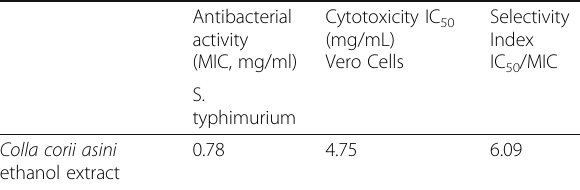
Table 4 Cytotoxicity (IC 50 in mg/mL) of Colla corii asini ethanol extract and selectivity index (SI) values against Vero cells